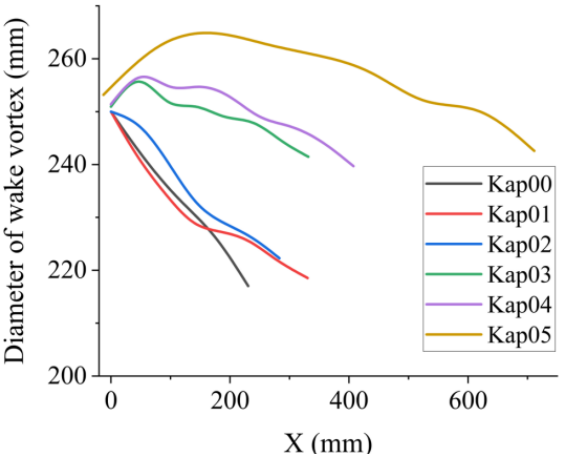
Figure 17. Tip-vortex diameter distribution of Kappel propellers with the wake length (the point where X = 0 stands for the center point of propeller disk.).